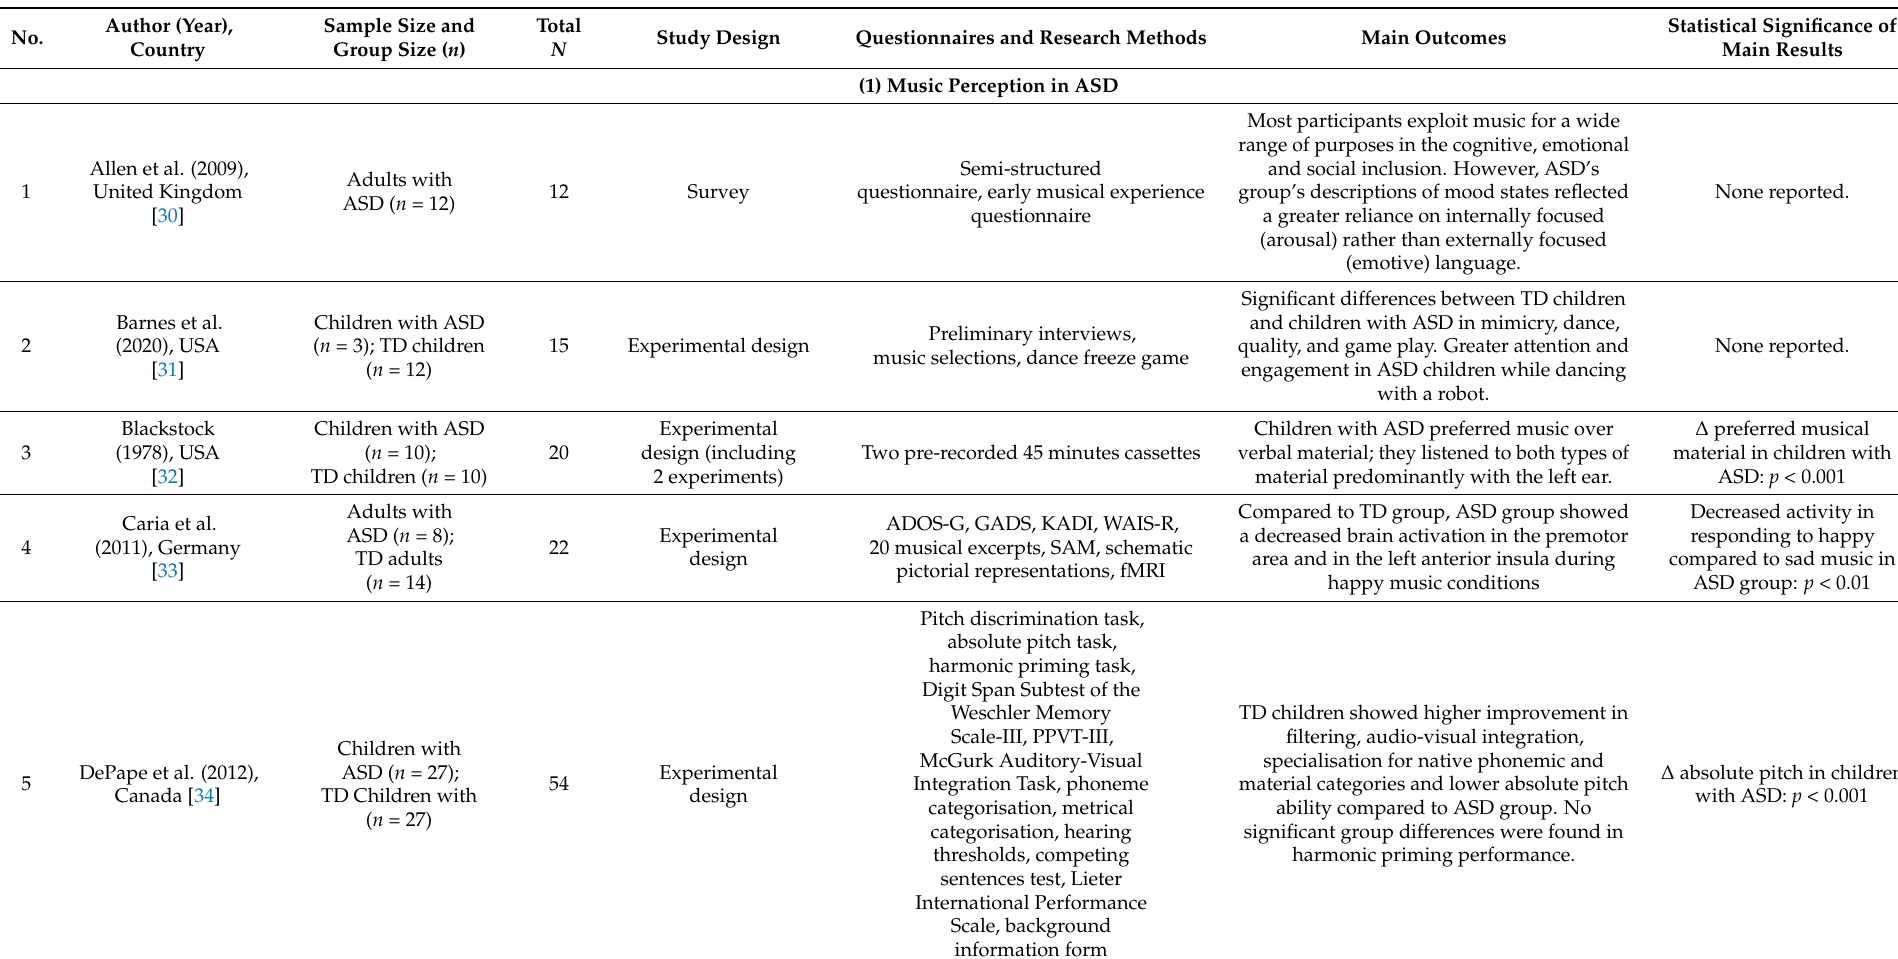
Table 1. Summary of the studies included in the systematic review. Studies are listed in alphabetical